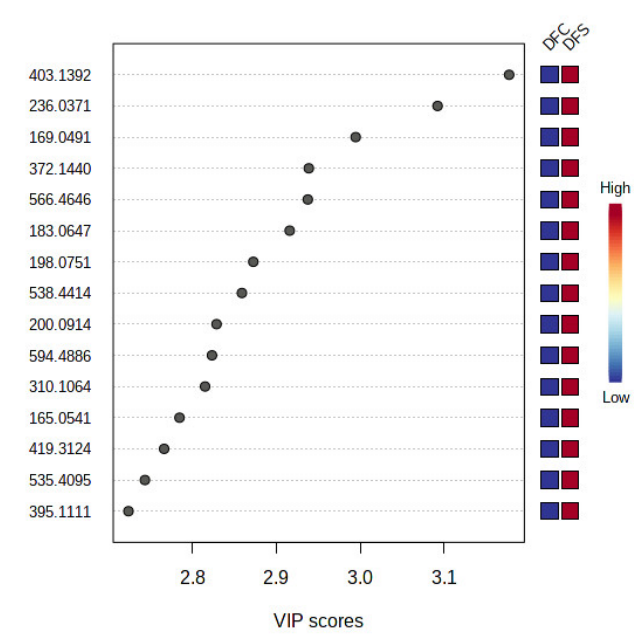
Figure 9. VIP score plot of the most important discriminant metabolites by PLS-DA for DFC and DFS. The relative abundance of each important metabolite is indicated with a colour code scaled from blue (low) to red (high). A high VIP score indicates a high impact of the metabolite as a discriminant feature among the sample groups.